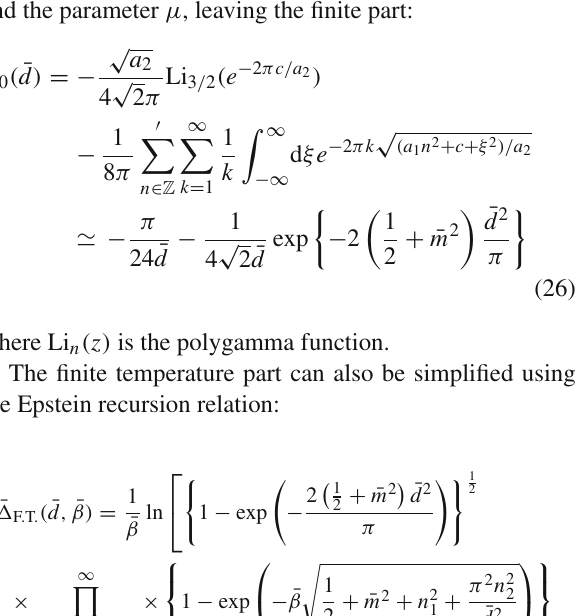
Fig. 2 Normalized Casimir energy of a scalar field as a function of normalized separation and temperature. ¯ m is set equal to